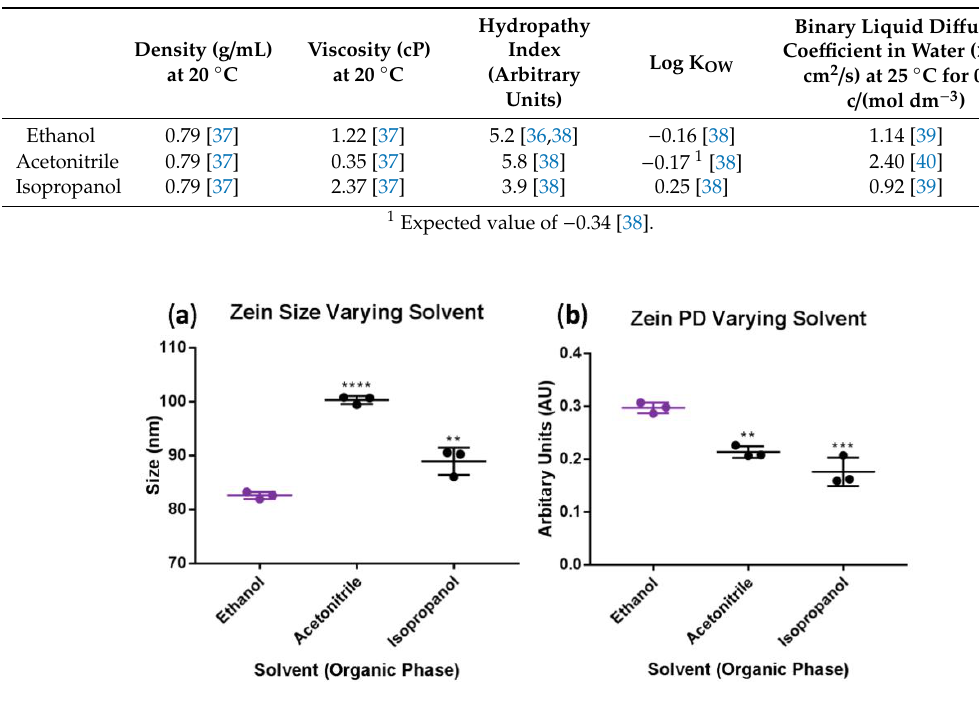
Figure 5. Impact of the solvent type on Zein nanoparticles (NPs): ( a ) diameter; ( b ) polydispersity (PD).